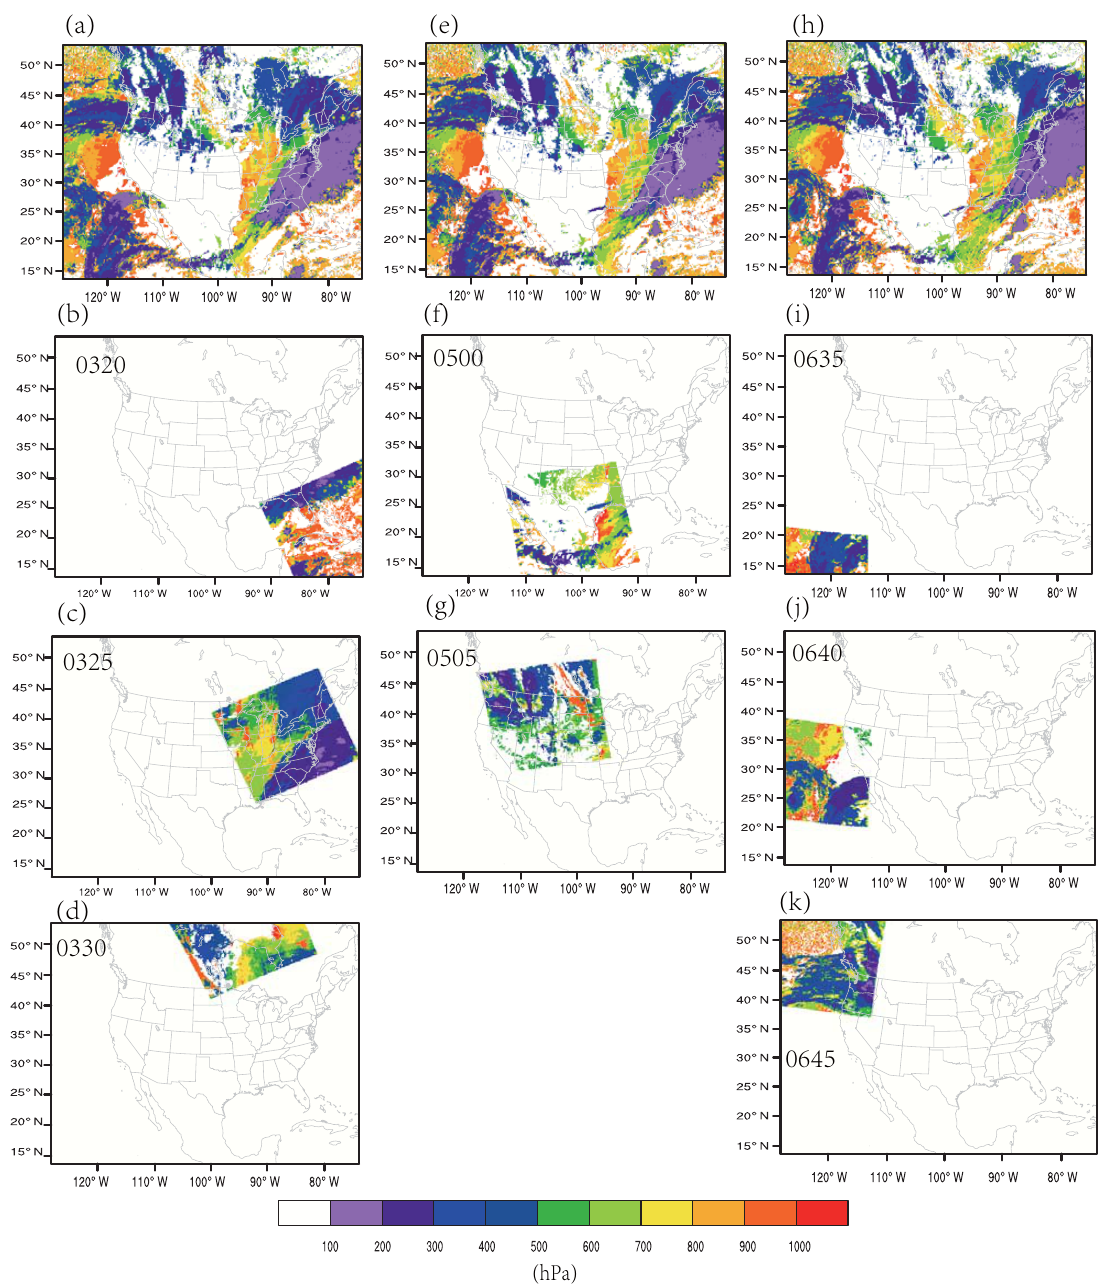
Figure 8. The cloud top pressure for (a) 03:00UTC from the GOES NASA retrieval; (b) 03:20UTC, (c) 03:25UTC and (d) 03:30UTC from MODIS level 2 products; (e) 05:00UTC from the GOES NASA retrieval; (f) 05:00UTC, (g) 05:05UTC; (h) 07:00UTC from the GOES NASA retrieval; (i) 06:35UTC, (j) 06:40UTC and (k) 06:45UTC from MODIS level 2